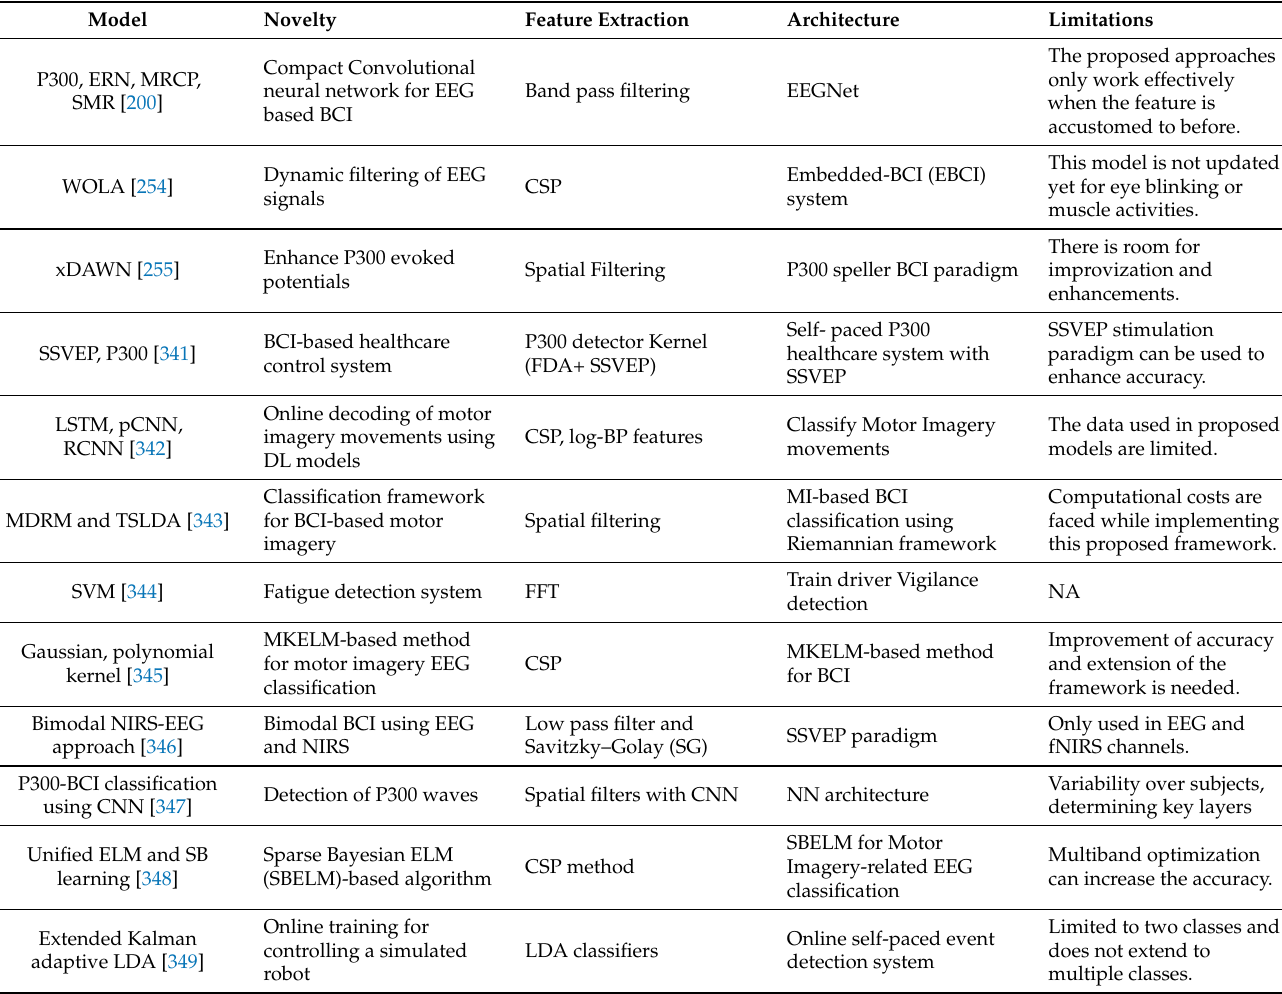
Table 10. A summary of some research papers proposing new methods of